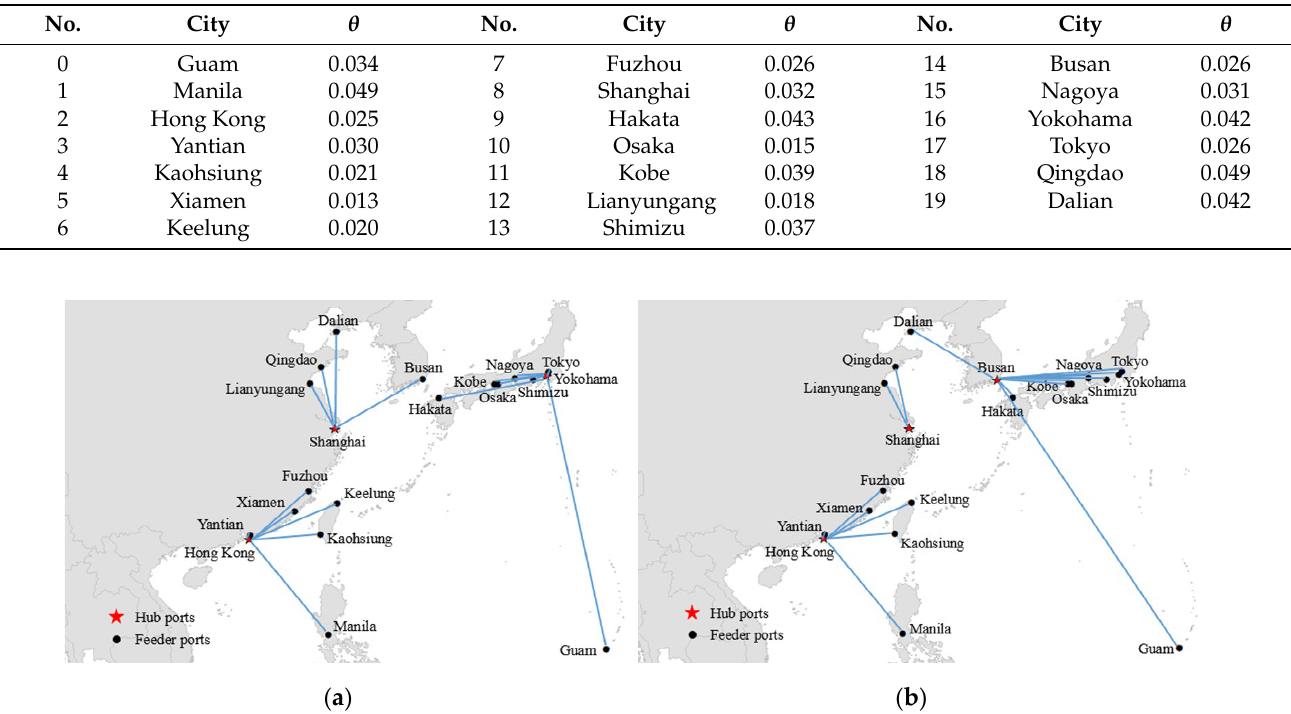
Figure 6. Hub location and feeder allocation under single allocation scheme. ( a ) CHLP, ( b ) RLSHLP. Table 2. Failure probability of each port in the RLSHLP.